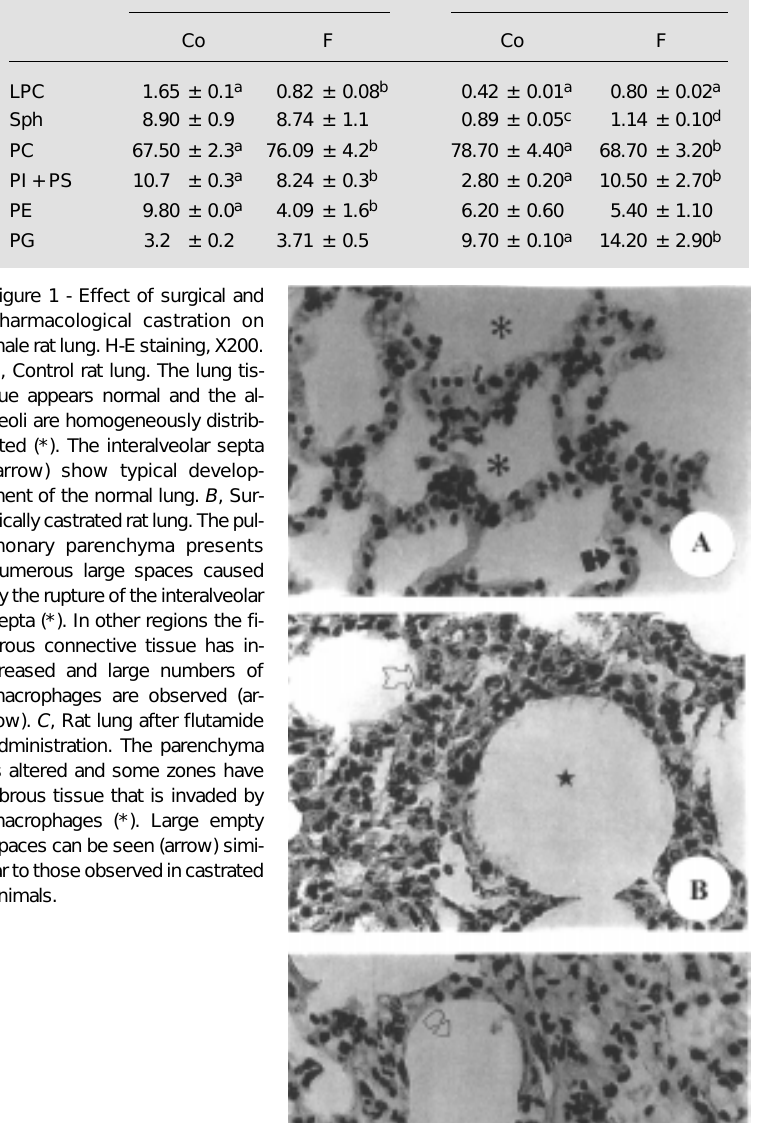
Table 2 - Phospholipid composition of microsomes and extracellular surfactant from male rat lung after administration of flutamide. Co: Control; F: control + flutamide; LPC: lysophosphatidylcholine; Sph: sphingomyelin; PC: phosphatidylcholine; PI + PS: phosphatidylinositol + phosphatidylserine; PE: phos- phatidylethanolamine; PG: phosphatidylglycerol. Data are reported as means ± SD for 8 rats in each group, expressed as percent of total phospholipids. a,b P<0.001, c,d P<0.01 by analysis of variance and the Tukey test.